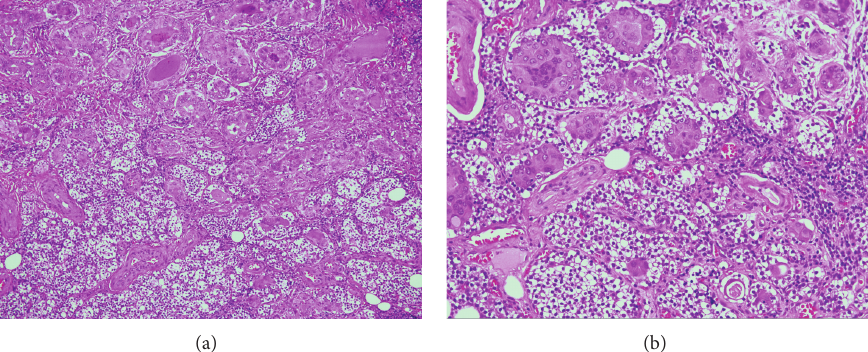
Figure 1: Papillary thyroid carcinoma, tall cell variant. The tumour invades the parathyroid widely, by an infiltrative growth (Haematoxylin & Eosin stain, × 20, (a)) (Haematoxylin & Eosin stain, × 40, (b)).